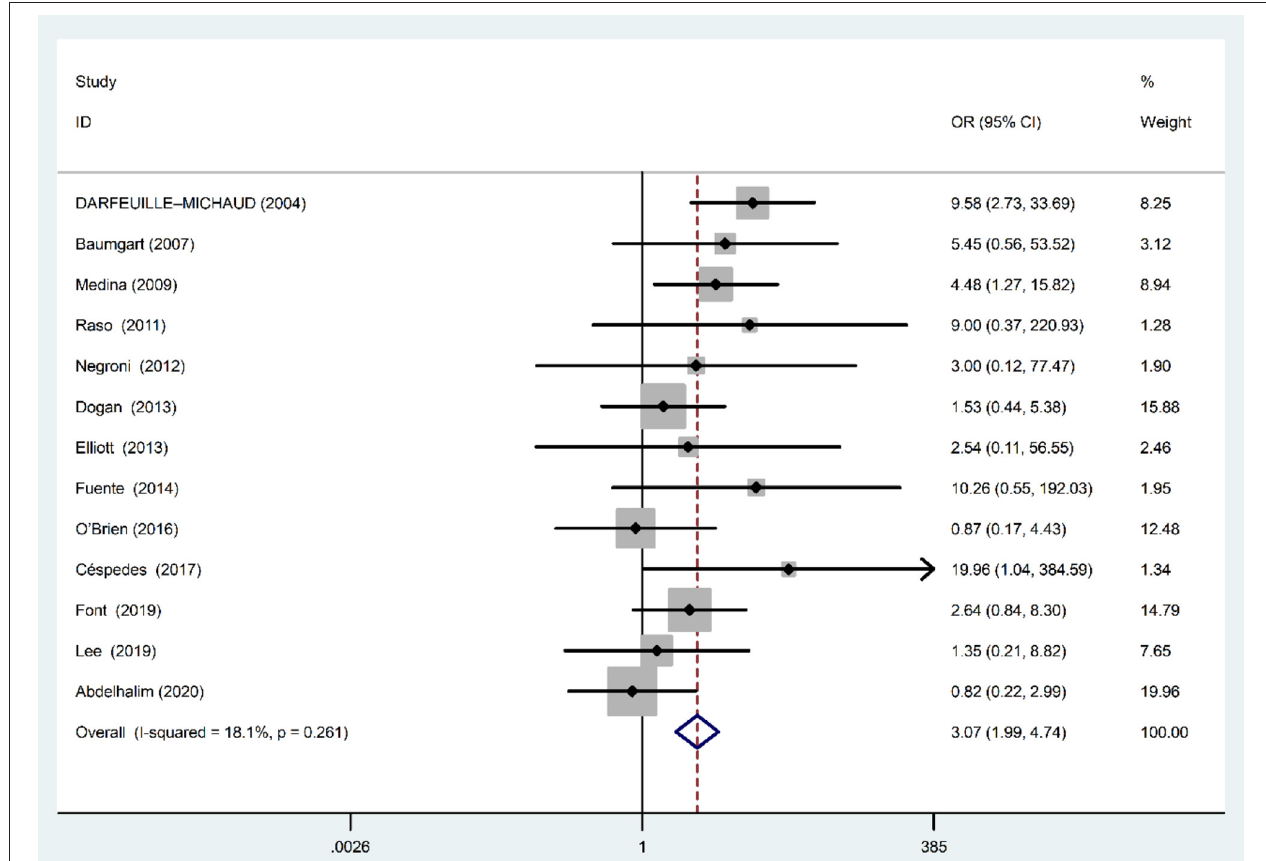
FIGURE 4 | Forest plot of the association between AIEC rate and risk of